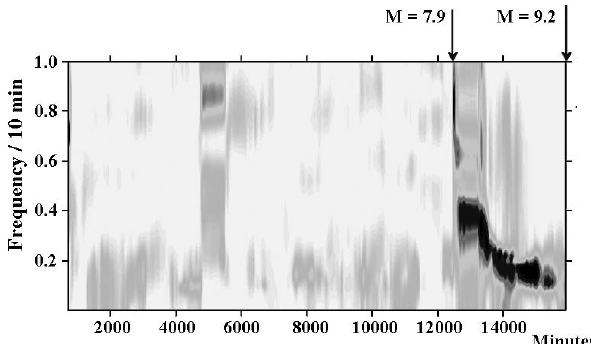
Fig. 17. Frequency-time diagrams of the evolution of the spectral measure of coherence λ(t,ω) for seismic records of the stations XAN (34.02 ◦ N–108.55E), KMI (25.07 ◦ N–102.44 ◦ E), CHTO (18.47 ◦ N–98.59 ◦ E), COCO (12.11 ◦ N–96.50 ◦ E). Arrows indicate successively time moments of Macquarie earthquake, M = 7 . 9, (49.31 ◦ S–143.91 ◦ E) and of Sumatra earthquake, M = 9 . 2, (3.32 ◦ N–95.85 ◦